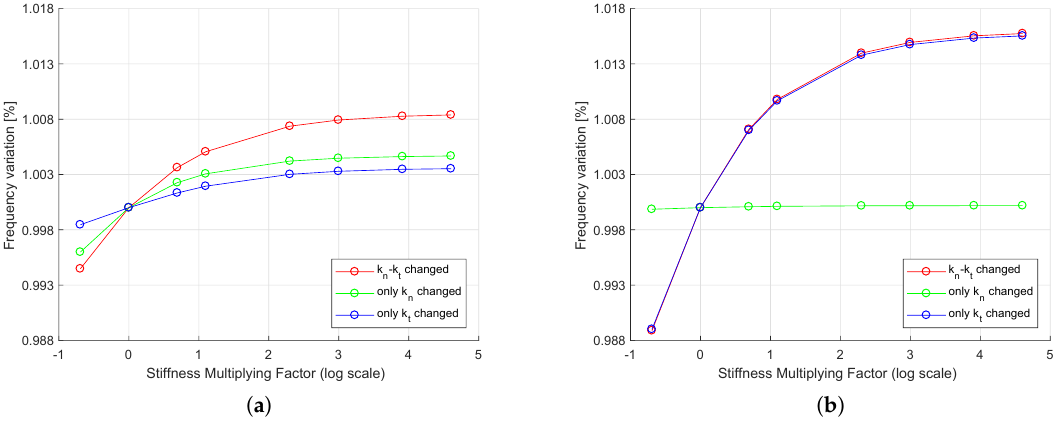
Figure 13. Neck-bending mode shape. ( a ) Influence of contact stiffnesses for In-Phase (IP) (1320 Hz) motion. ( b ) Influence of contact stiffnesses for Out-of-Phase (OOP) (1366 Hz)